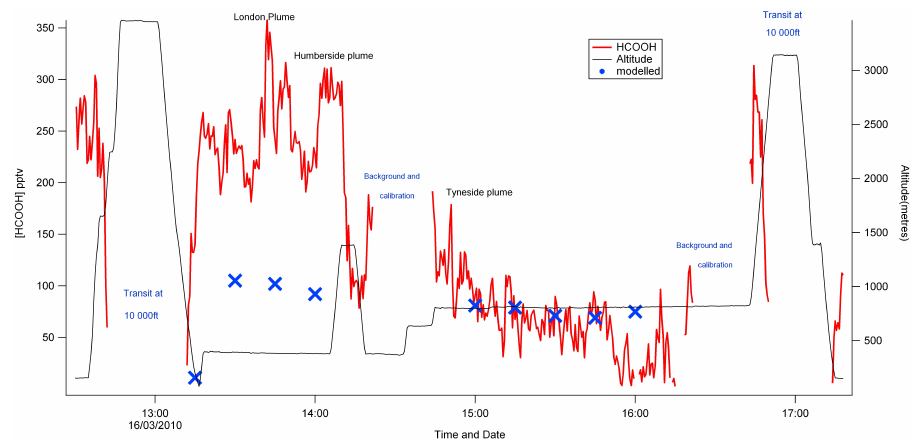
Fig. 4. Time series of 30-s averaged formic acid observations (left axis) with altitude (right axis) from the 16 March 2011 flight. The London, Humberside and Tyneside plumes have been labelled. Sections of the flight where there are backgrounds, calibrations and transits are set to zero, and comparison with back trajectory modelled data is